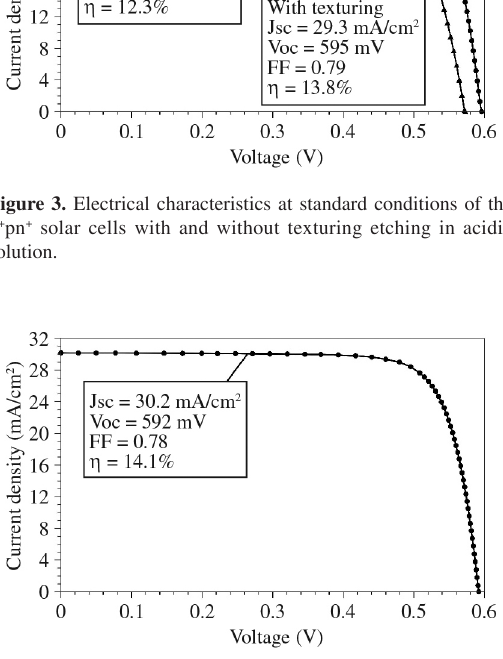
Figure 2. n + pp + silicon solar cell manufacturing process.